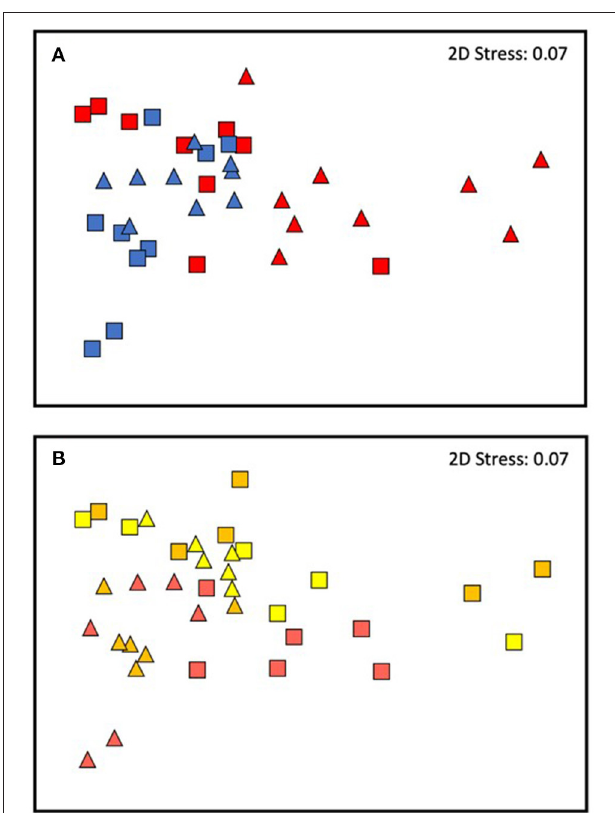
FIGURE 7 | Future MHWs. nMDS of the interaction between Time and Origin (A) and Temperature and Origin (B) . In the upper ordination (A) : red, warm origin; blue, cold one; triangles, T2 and squares, T3. In the lower ordination (B) : triangles, cold origin; squares, warm origin; yellow, CT; orange, MT; and red,